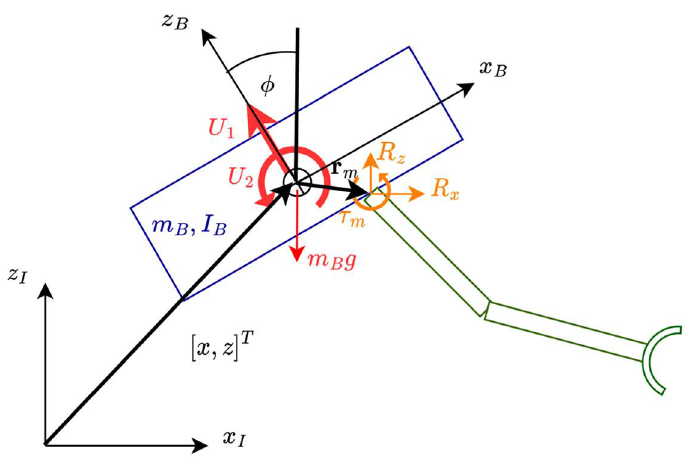
Figure 2. Coordinates and forces of the UAM. UAV forces/torques are in red and manipulator reaction forces/torques are in orange. The UAV is shown in blue and manipulator in green.